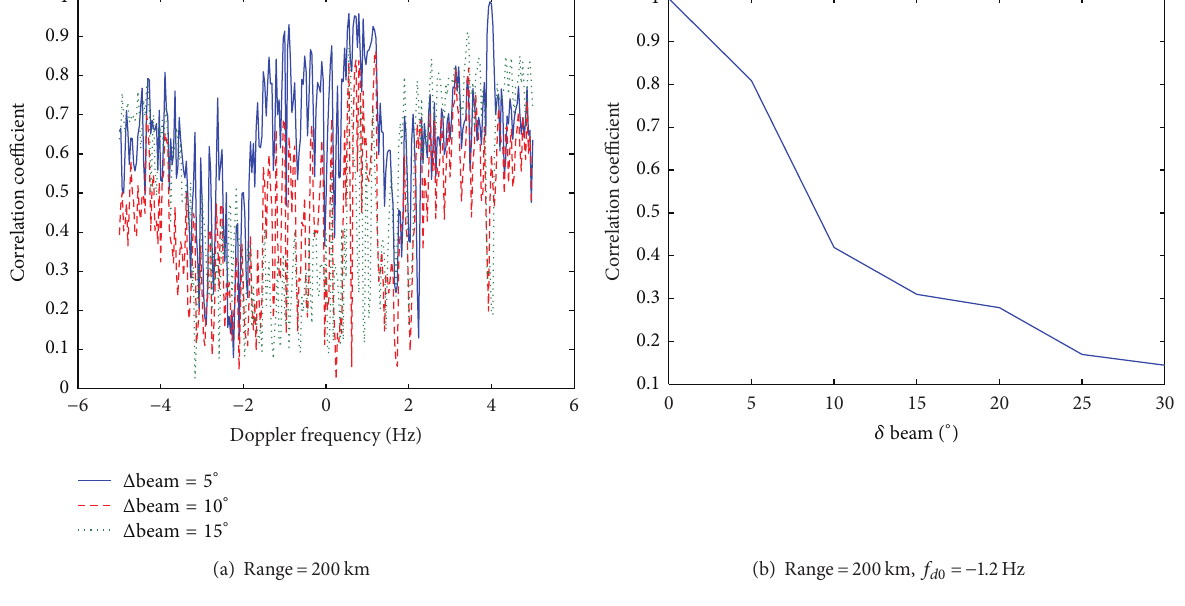
Figure 3: Correlation coefficients with different beam intervals.